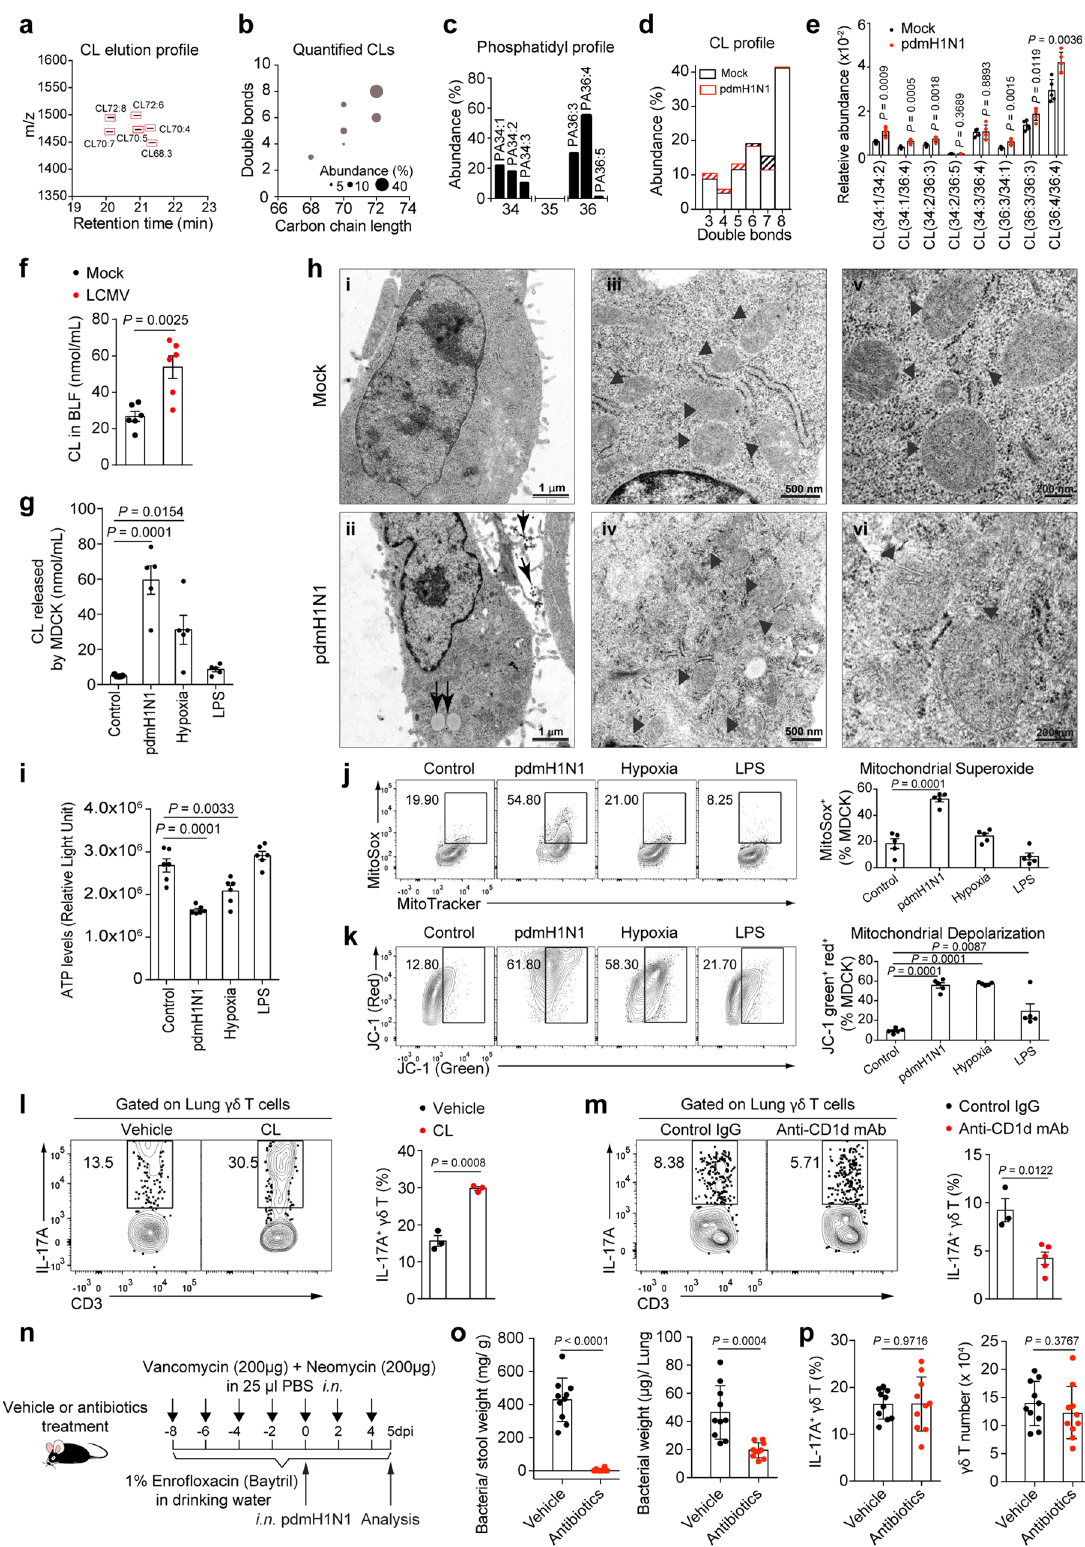
clusters included a signi fi cant degree of conservation between mouse and human (Fig. 7l). A small portion of these cells in population two are AQP3 + IL23R + and RORC + , suggestive of T γδ 17 identity (Fig. 7m). Pseudotime trajectory analysis of cluster T γδ 17 further showed that IRF4 and IL23R expression were